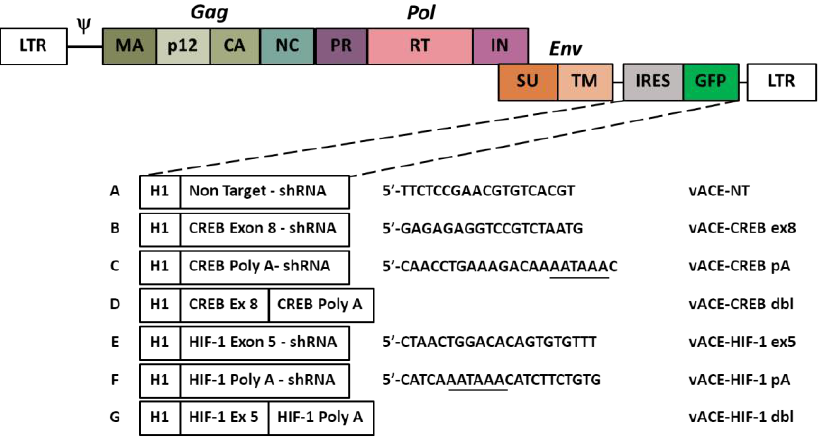
Figure 1. Schematic presentation of the various shRNAs recombinant replication competent retroviruses (RCRs). The IRES- GFP cassette from vACE was replaced by a H1 promoter which drives the expression of shRNAs targeting CREB or HIF-1. ( A ) A non-target (NT) sequence was used as control sequence for the e ff ect of vACE alone on the tumors. ( B , E ) shRNA sequences targeting CREB ( B ) and HIF-1 ( E ) [14,16]. ( C , D , F , G ) To increase knockdown e ffi ciency and minimize resistant mutations, we added shRNAs against the poly(A) signal (underlined) of each target. ( D , G ) Armed retroviruses carrying two shRNA sequences against the same target were termed: “double” (dbl).